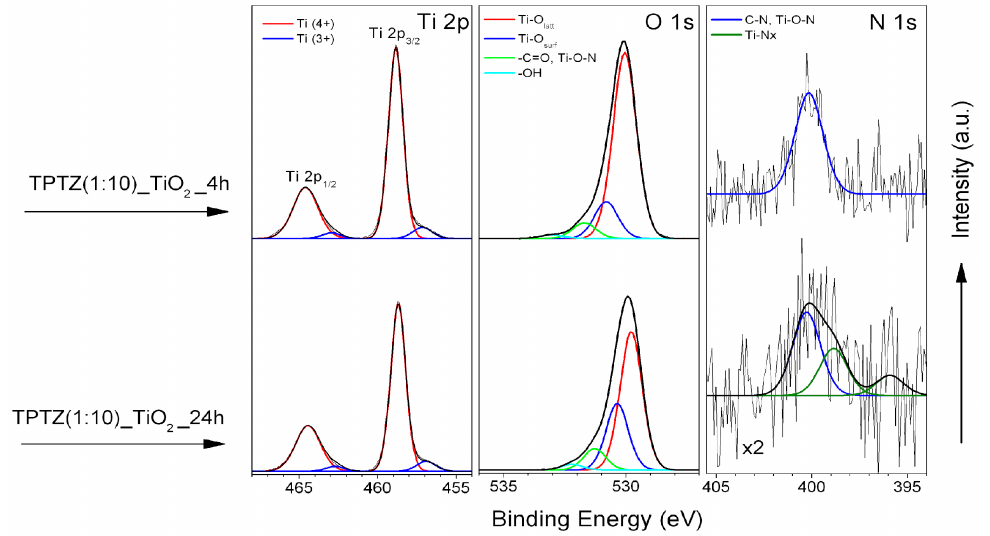
Figure 8. HR XPS spectra of Ti 2p, O 1s and N 1s for TPTZ(1:10)_TiO 2 after various preparation time periods.